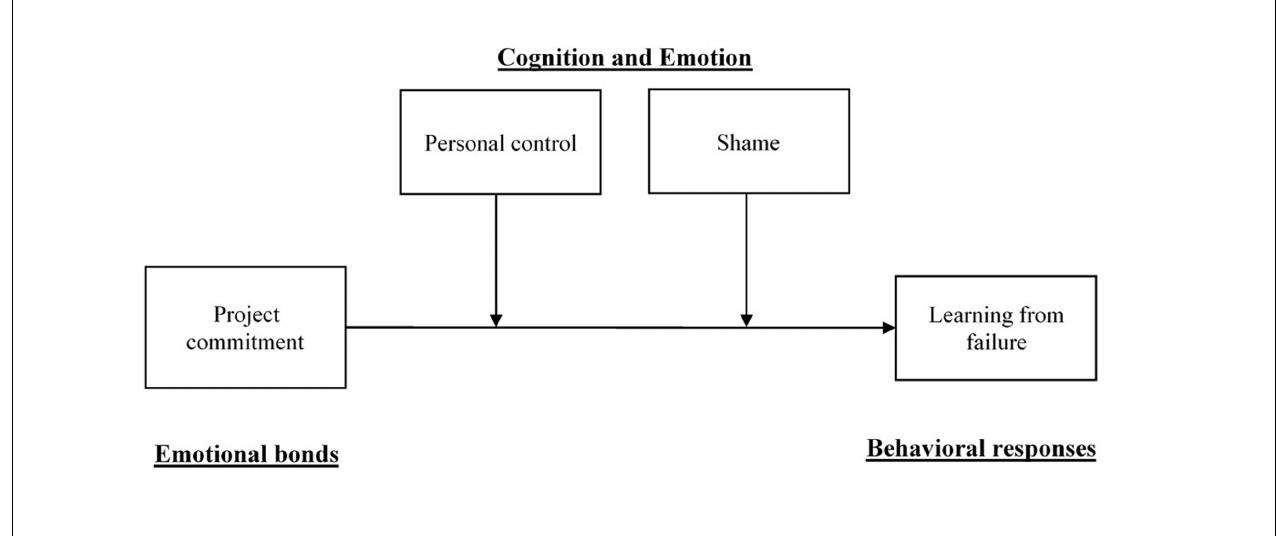
FIGURE 1 | Theoretical